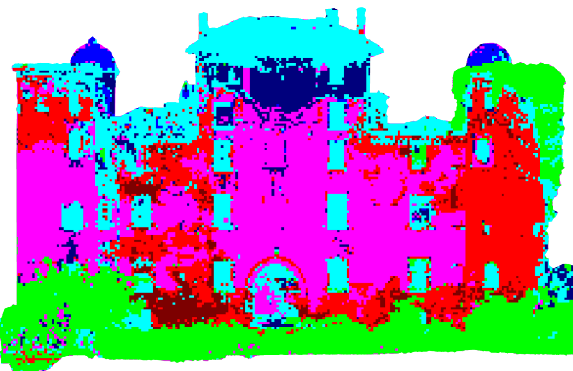
Figure 10. Orthophoto resulting from the image classification with ML, using Random Forest classifier.